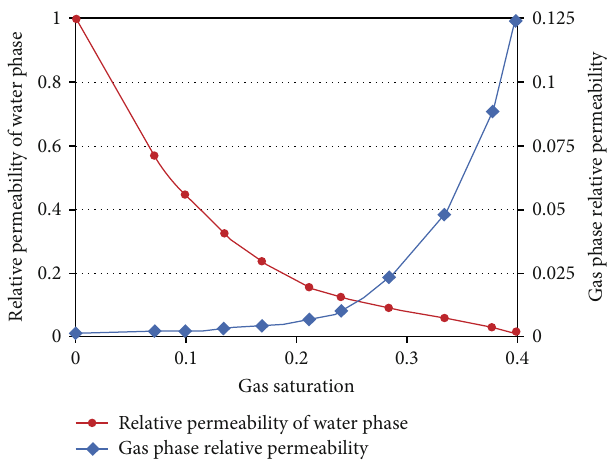
Figure 10: Gas-water relative permeability curve in single medium.